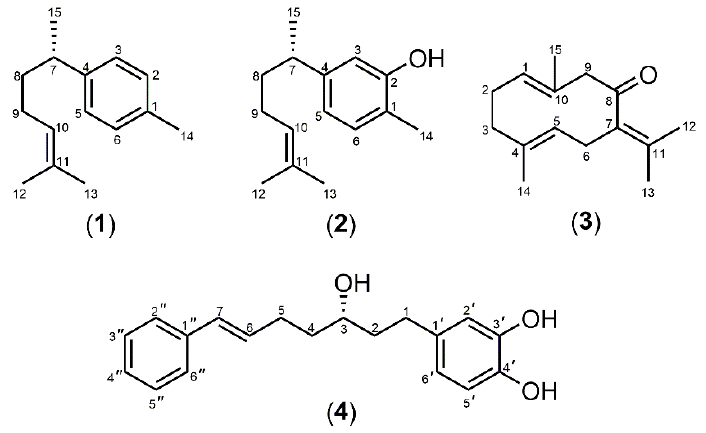
Figure 1. The structures of marker compounds of C. aromatica ( 1 – 3 ) and C. comosa ( 4